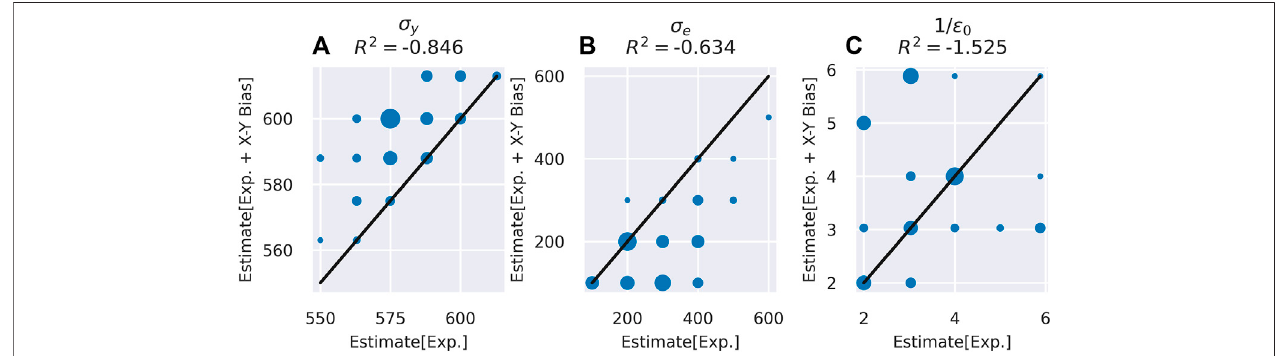
FIGURE8| Scatterplotsofthe X-Y bias ’ seffectonthePIPpredictionsoftheVoceparametervaluesforthe84pro fi lesinthereducedset (A) yieldstress (B) excess stress (C) 1/ ε 0 .